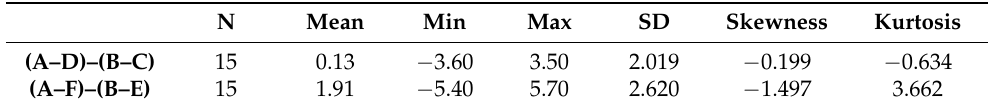
Table 3. Basic statistics of the difference in bilateral measurements of the maxillary alveolar process— test